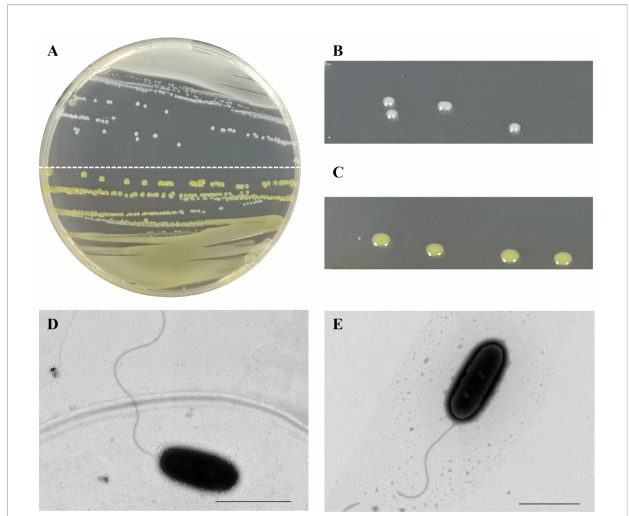
FIGURE 1 Colony and cell morphology of two strains of Acidovorax avenae subsp. avenae isolated from sugarcane in China. (A) Colonies of strain CNGX08 (white-cream; upper half plate) and strain CNGD05 (yellow; lower half plate) growing on a nutrient agar (NA) medium plate. (B, C) Close up view of the colonies of strains CNGX08 and CNGD05, respectively. (D, E) Cell morphology of strains CNGX08 and CNGD05 observed by transmission electron microscopy (×10,000), respectively. The scale bar corresponds to 2.0 µm.